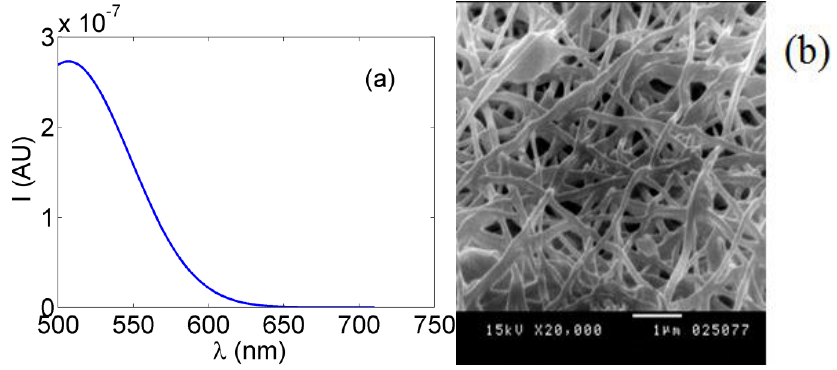
Figure 7. ( a ) Fluorescence intensity of spin-coated ceria NPs on crosslinked PVA NFs and ( b ) SEM image of the crosslinked PVA NFs.